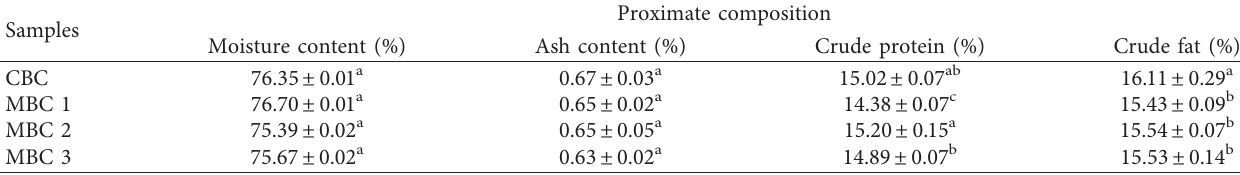
Table 4: Proximate composition of broiler chicken meat obtained from a genuine supplier and three different